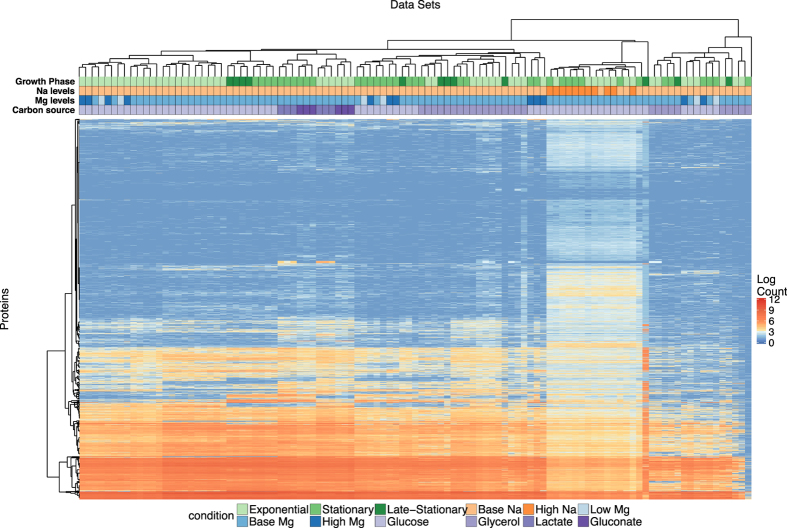
Clustering of protein abundances.The heatmap shows 4196 protein abundances for each of 105 samples, clustered both by similarity across genes and by similarity across samples. The growth conditions for each sample are indicated by the color coding along the top of the heatmap; the color coding is defined in the legend at the bottom.